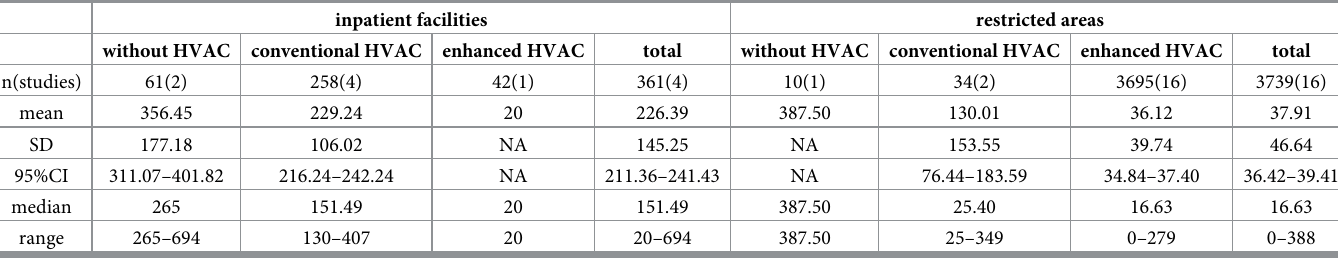
Table 3. Mean bacterial counts in different areas of hospitals (CFU/m 3 ).